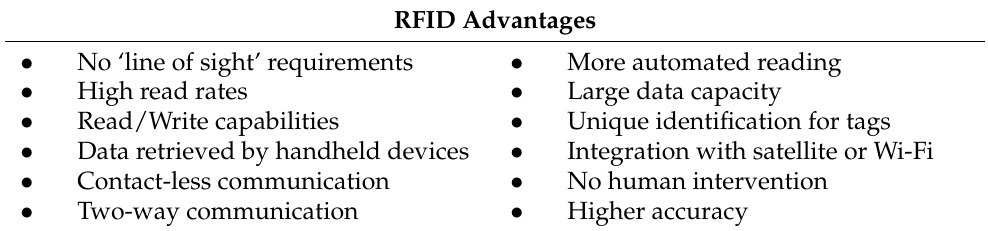
Table 1. RFID advantages (adapted from